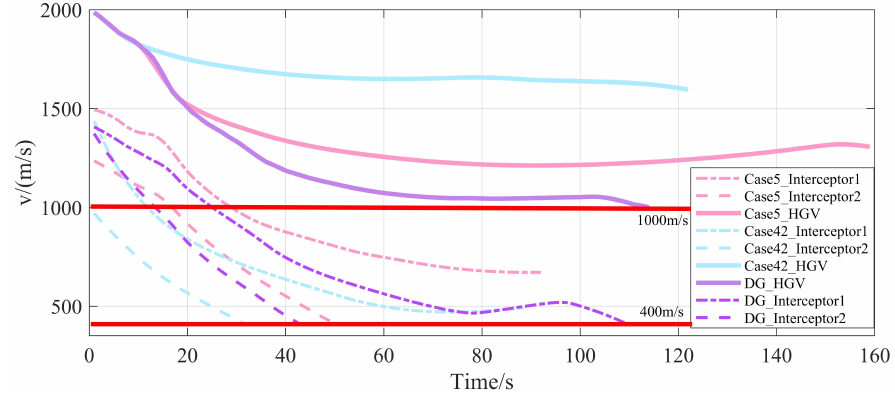
Figure 11. Velocities comparison between RBT-DDPG(Cases 5 and 42) and Differential Game. The neural network chooses to dive before leaping in Case 5, whereas, in Case 42, it takes a direct leap. Furthermore, while the peak in Case 5 is 60 km, it only reaches 54 km in Case 42 before diving. In both cases, the HGV causes one of the interceptors to go below the minimum flight speed (400 m/s) before entering the rendezvous phase. At the rendezvous phase, the minimum distances between the interceptor and the HGV are 389 m and 672 m, respectively, which indicates that the HGV is almost within the interceptable area of interceptors. The terminal velocity of the HGV in Case 5 is approximately 100 m/s lower than that in Case 42, due to the higher initial interceptor energy faced in Case 5, which resulted in a longer manoeuvre path and a more violent pull-up in the dense atmospheric region. Figure 12 illustrates that the HGV tends to perform a large overload manoeuvre in the approach phase, almost exclusively utilizing the manoeuvring ability. In the regress phase of Case 42, only very small magnitude manoeuvres were required to correct the ballistic inclination, demonstrating that the neural network can control the HGV and select the appropriate ballistic inclination for the dive after escaping the